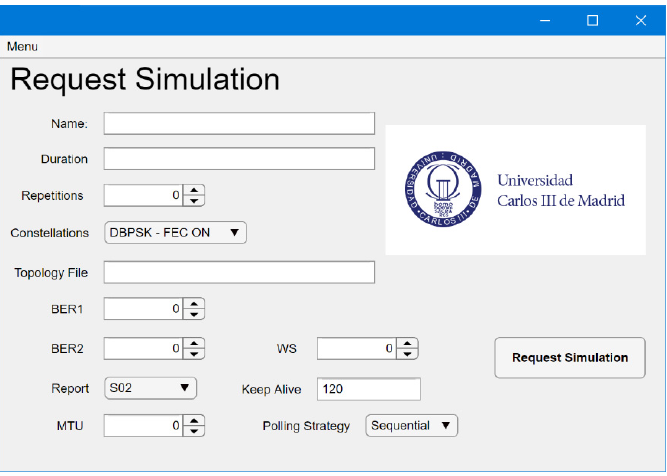
Figure 4. Screen to configure and execute SimPRIME simulations.